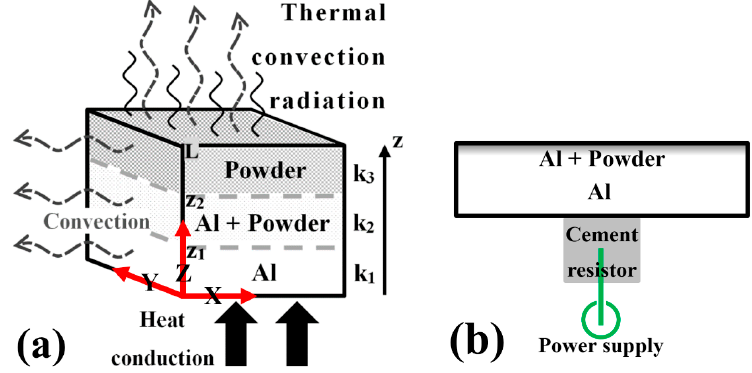
Figure 1. Illustration of ( a ) the concept and ( b ) the experimental setup of heat dissipation.